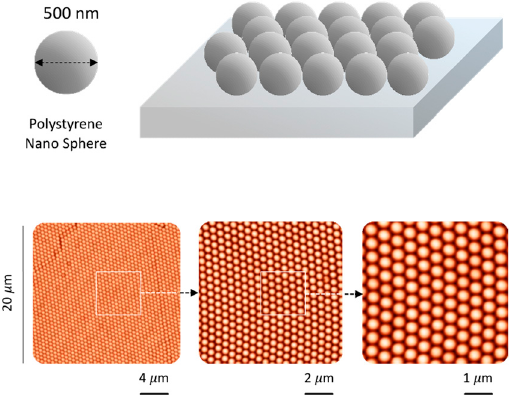
Figure 3. Schematic illustration, low and high magnification AFM images of the CPA realized on glass substrate with Polystyrene NS of 500 nm in diameter.